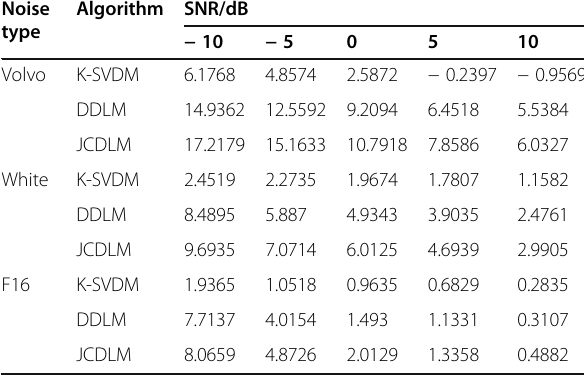
Table 4 Increment of SNR in different noise environments (dB) Noise Algorithm type